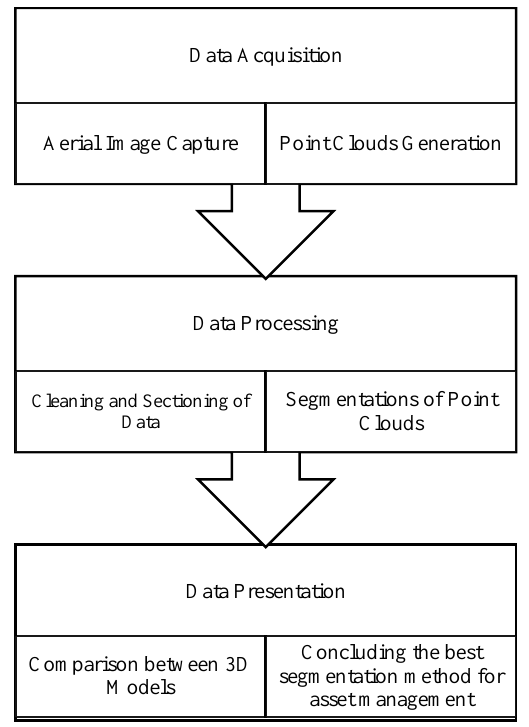
Figure 2: Flow of